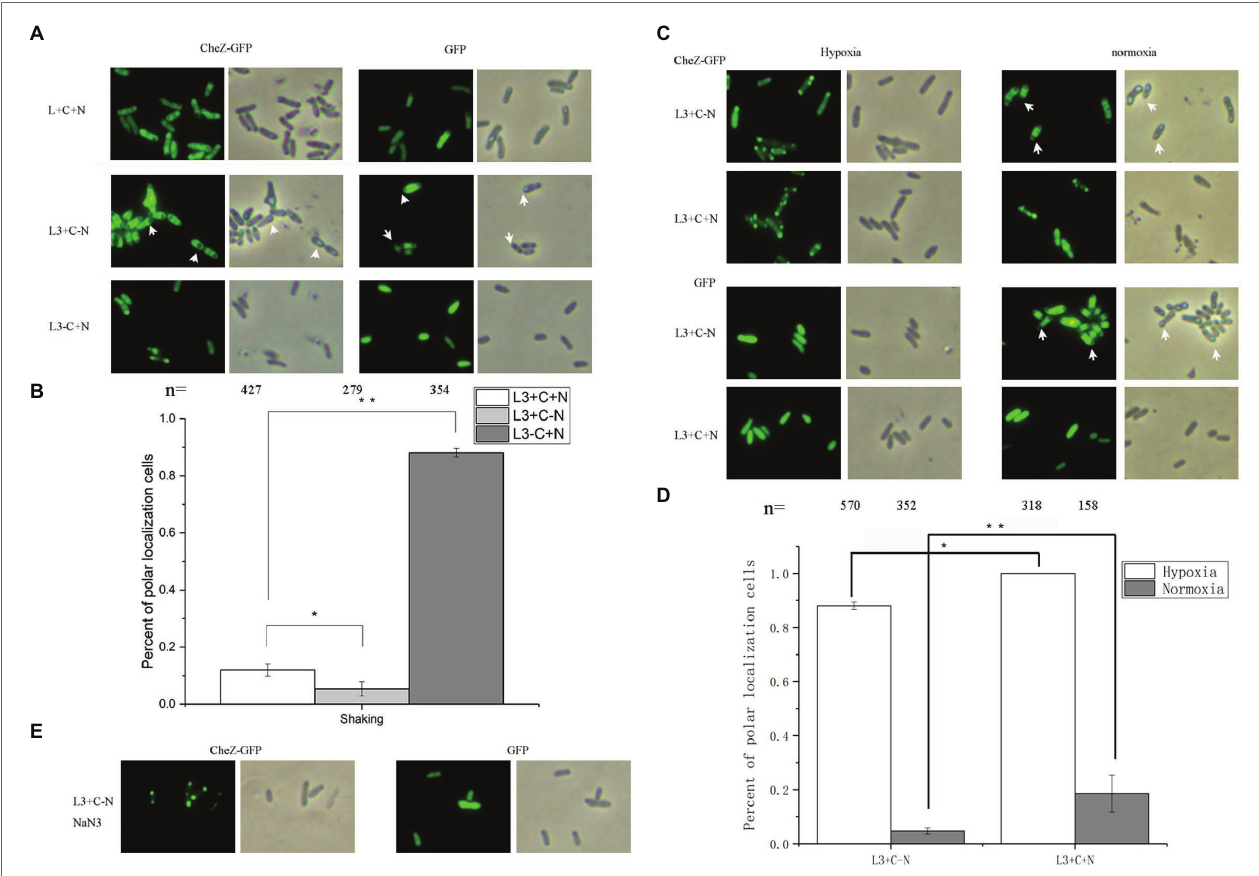
FIGURE 7 | Localization of CheZ under nitrogen limiting and free-living nitrogen fixation conditions. (A,B) Images and quantified data of cells of A. caulinodans ORS571 under nitrogen limiting conditions (shaking with normoxia and without nitrogen source). (C,D) Representative images and quantification of cells with polar localization of CheZ under hypoxia conditions of nitrogen fixation (hypoxia without nitrogen source) or non-nitrogen fixation (hypoxia with nitrogen source; C left panel and D ). Then the cells are transferred from under hypoxia conditions of nitrogen fixation conditions (hypoxia without nitrogen source) or non-nitrogen fixation (hypoxia with nitrogen source) to normoxia conditions ( C right panel and D ). The effect of nitrogen limiting on localization of CheZ depends on the energy status of cells (E) . The carbon limiting condition was used as a control. Data are means ± SDs from at least three independent experiments. Asterisks (* p < 0.05, ** p < 0.01) show a significant difference between two samples according to t